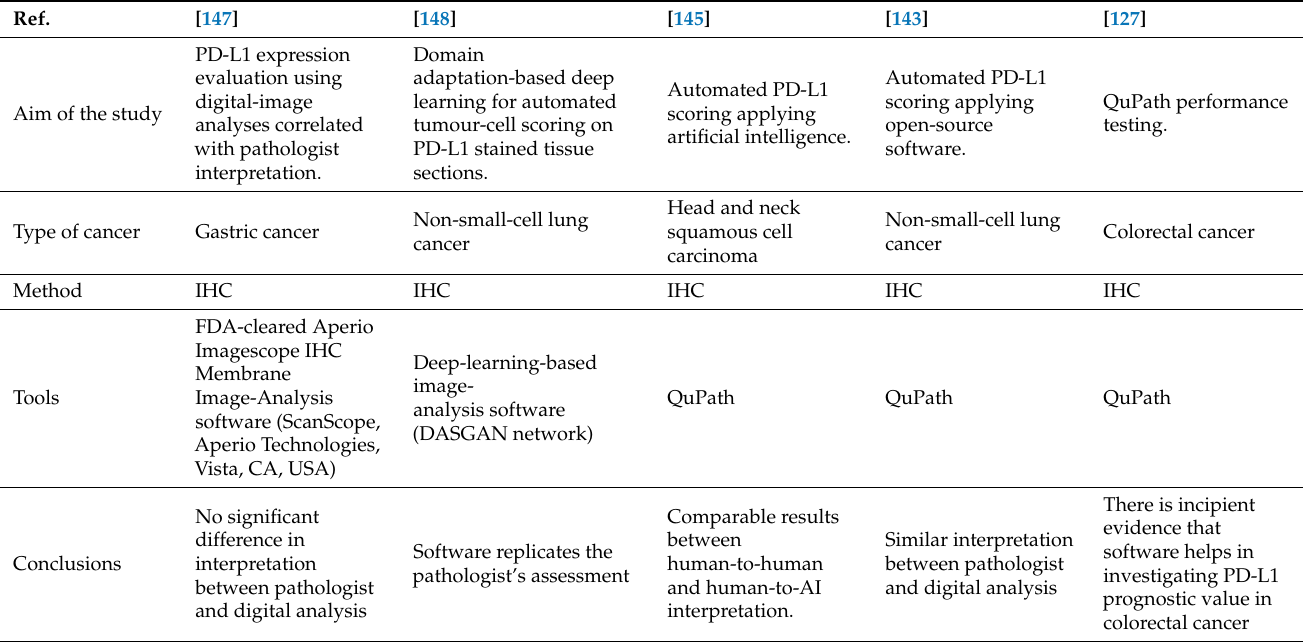
Table 3. Overview of AI-assisted methods of digital pathology for PD-L1